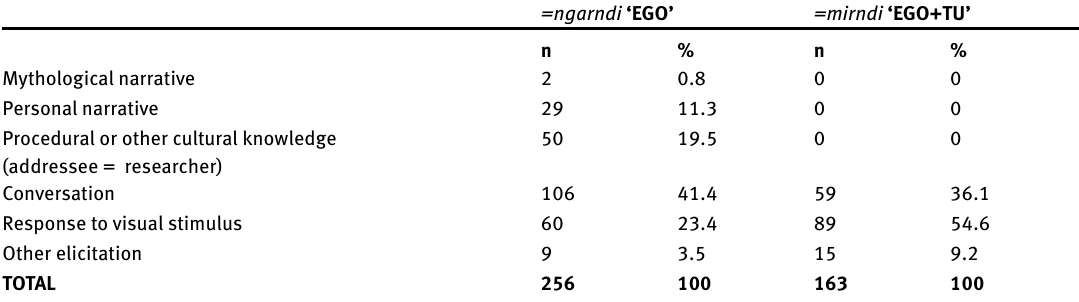
Table 3 : Distribution of =mirndi ‘EGO+TU’ across different genres in the reference corpus. Information for =ngarndi ‘EGO’ (Table 2) included for ease of comparison.